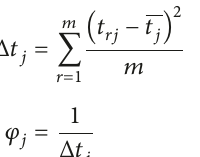
than the combination of merging form in Figure 2, and the floor entrance is set according to the evacuation character of pedestrian flow rate. Type6 describes that the one floor entrance is adjacent to the incoming stair, and the other floor entrance faces toward incoming stair (Figure 3(a));